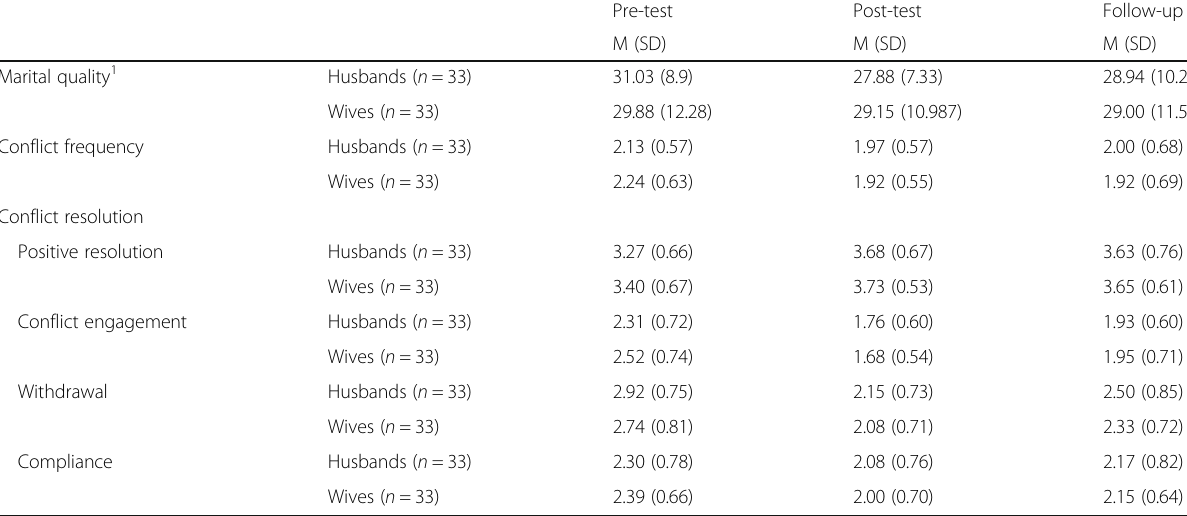
Table 6 Means and standard deviation for husbands and wives who completed the pre-test, post-test, and follow-up Pre-test Post-test